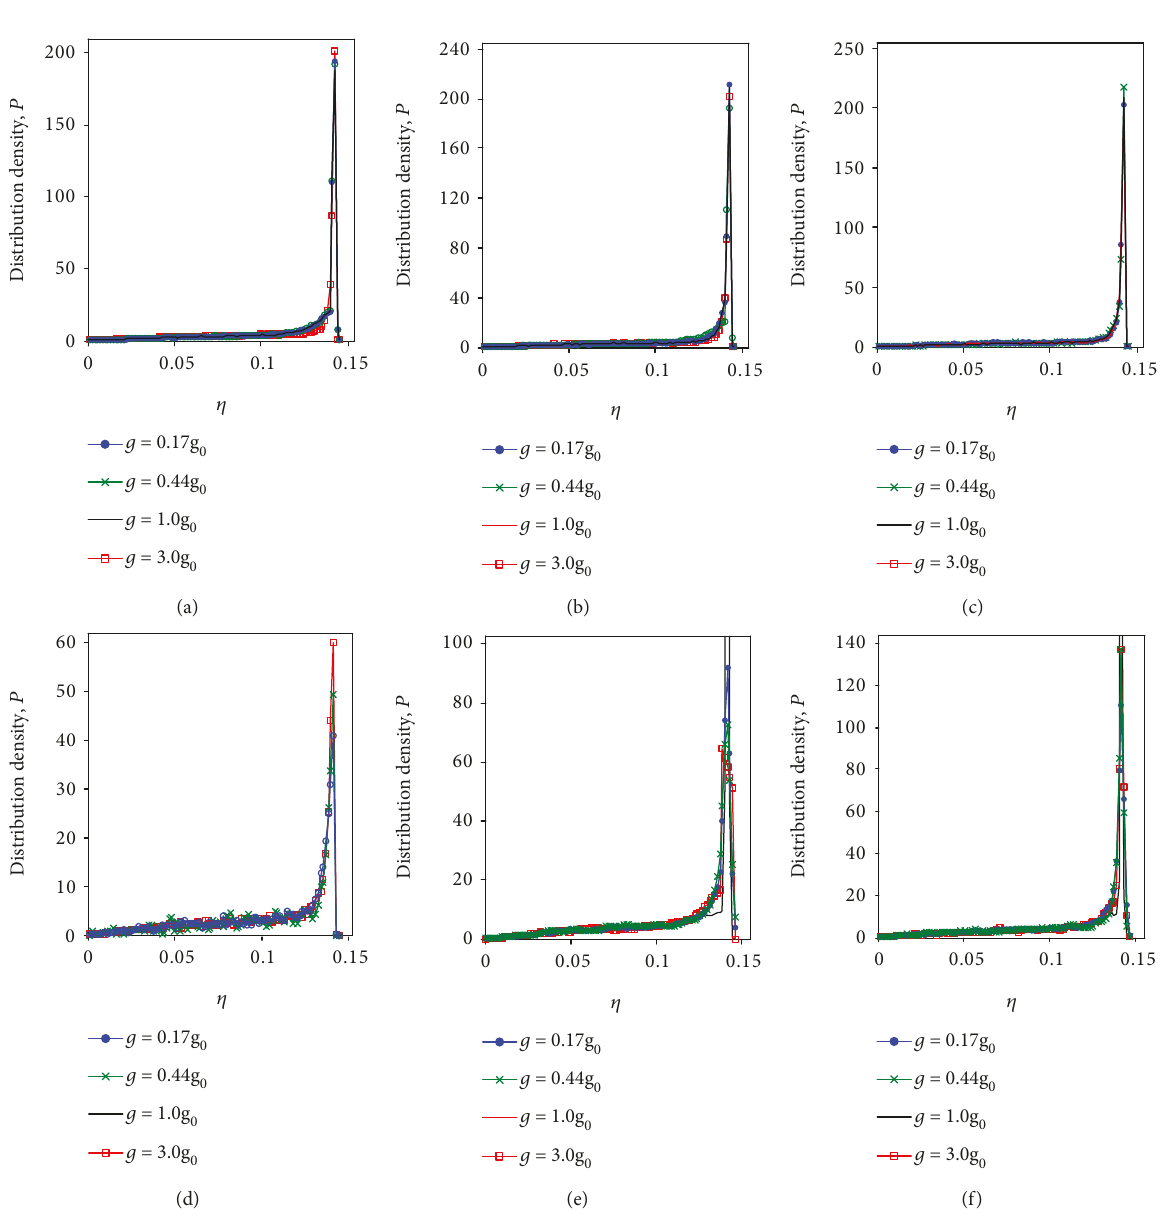
/ F ) in the particulate pile under di ff erent gravity accelerations for particle sample: (a) S t n